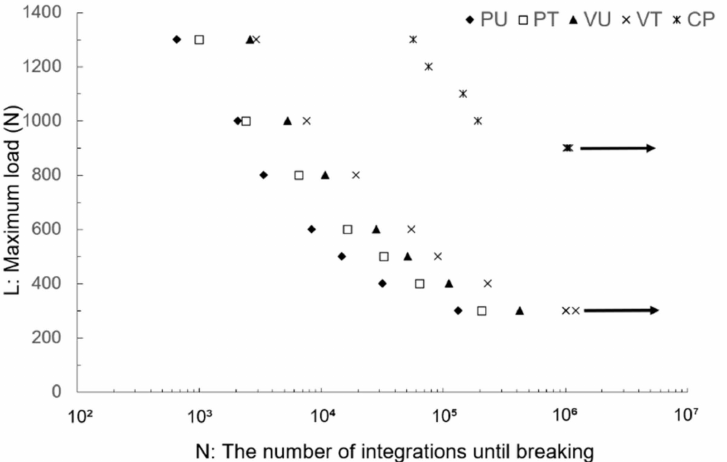
Figure 6. Bending fatigue test results. The L–N curve is shown. The VT specimens do not break even if the number of integrations is 10 6 or more at 300 N (the fatigue limit). The arrows indicate no breakage.